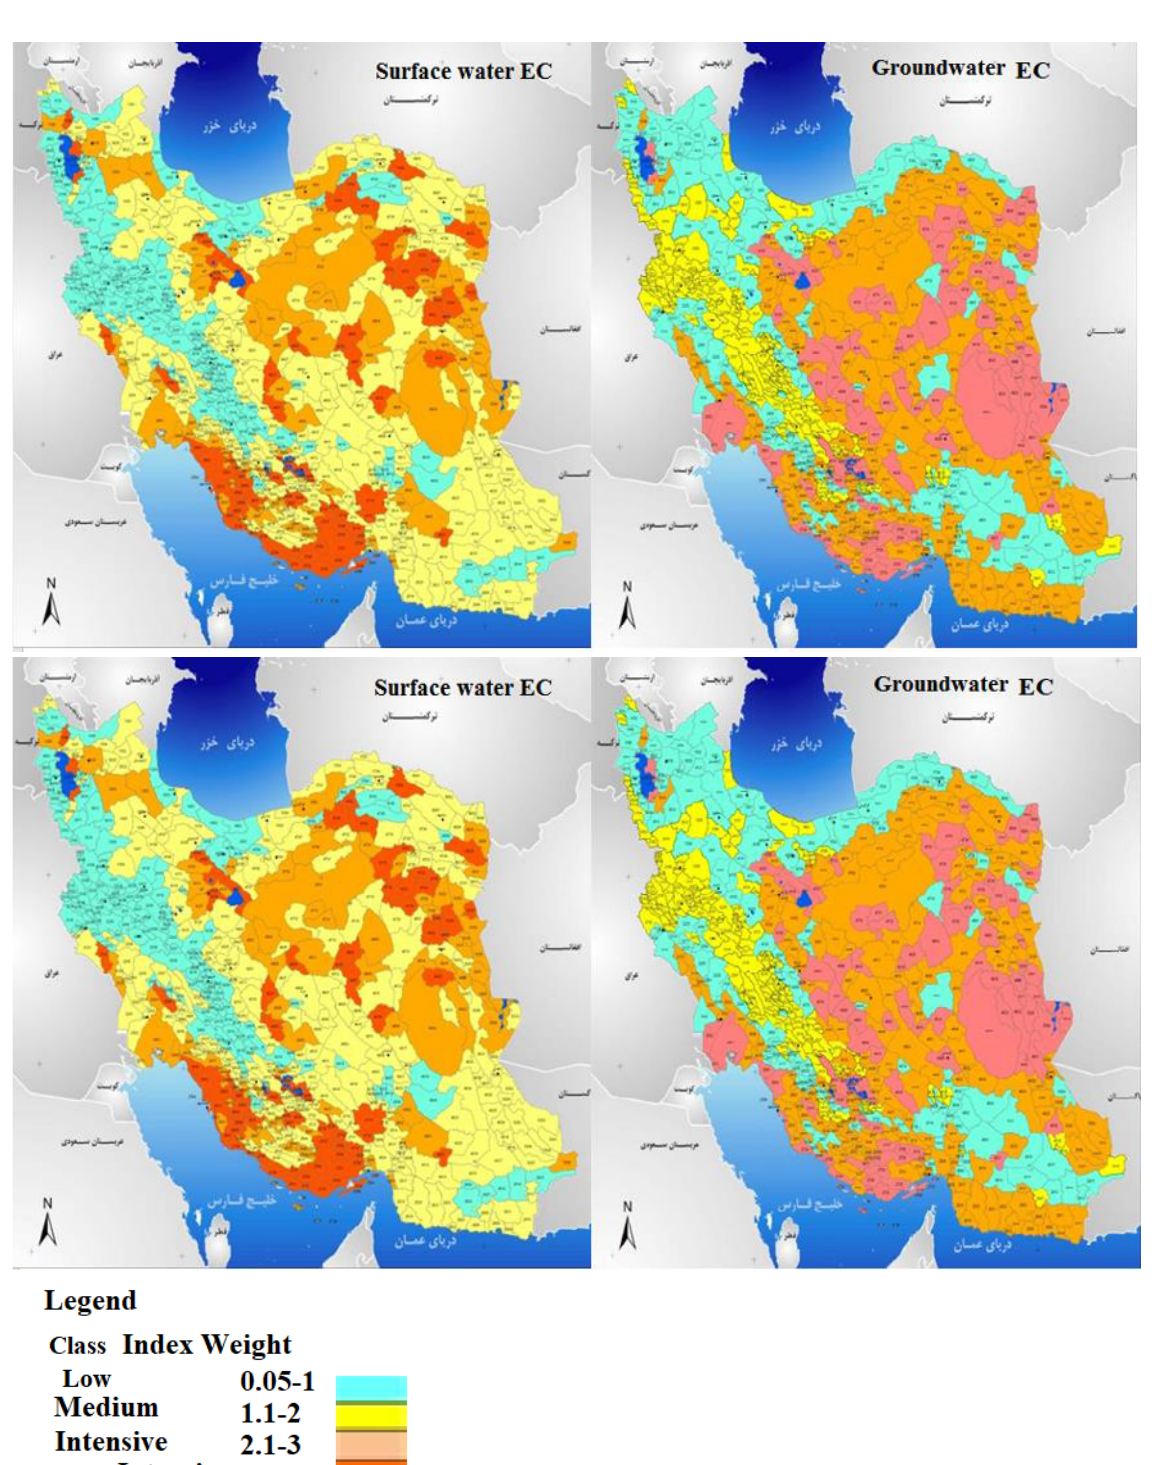
Figure 2. The map of water and irrigation